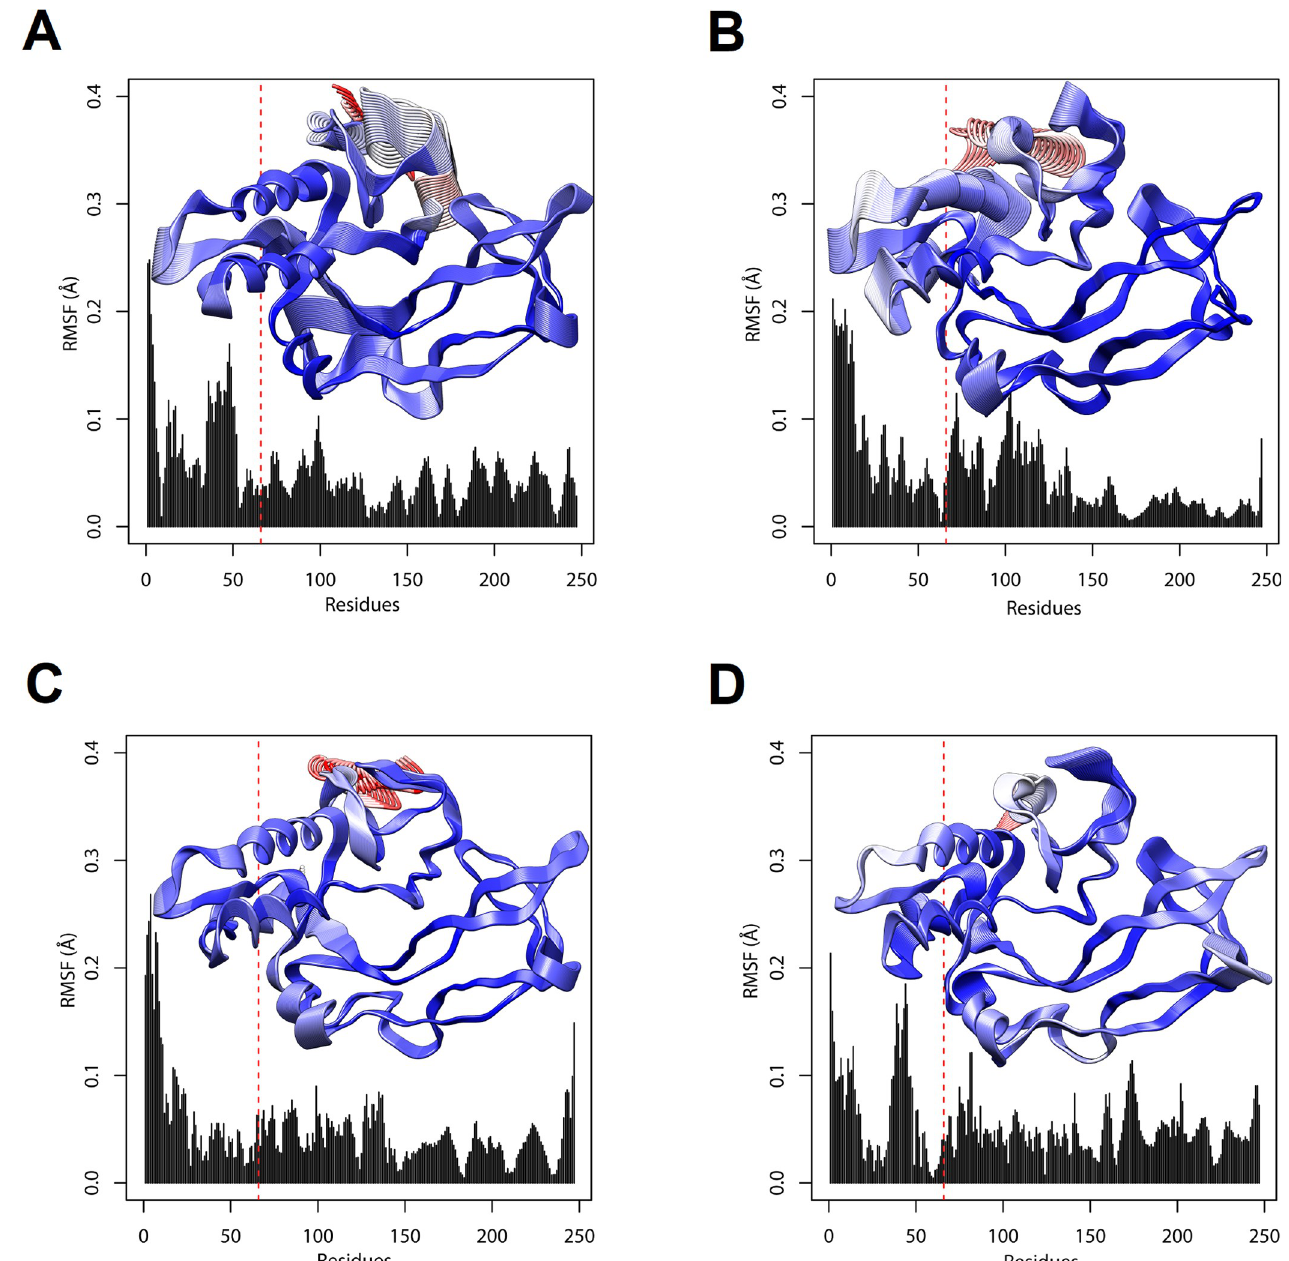
Fig 12. Visualization of the first two principal components on the structure of wild-type BDNF and its variant V66M. The RMSF contribution of each protein residue to the first two principal components (PC1 and PC2) is displayed within their respective plot and projected on the corresponding structural location. RMSF magnitude is represented by a coloring-thickness scheme, which scales from thin and blue (low fluctuations) to thick and red (large fluctuations). The dashed red lines show residue 66. (A) RMSF contribution of wild-type to PC1. (B) RMSF contribution of variant V66M to PC1. (C) RMSF contribution of wild type to PC2. (D) RMSF contribution of variant V66M to